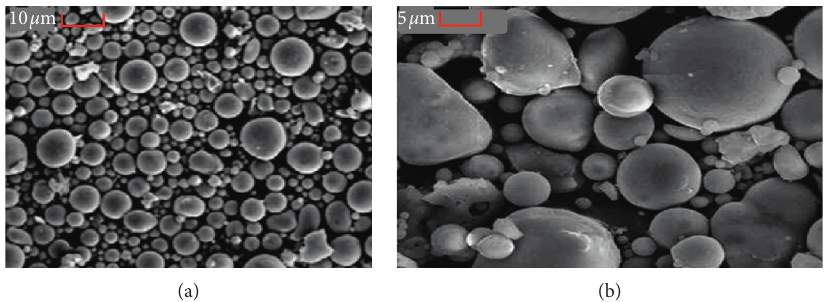
Figure 5: SEM images of fly ash at different magnifications: (a) 10 μ m scale and (b) 5 μ m scale.